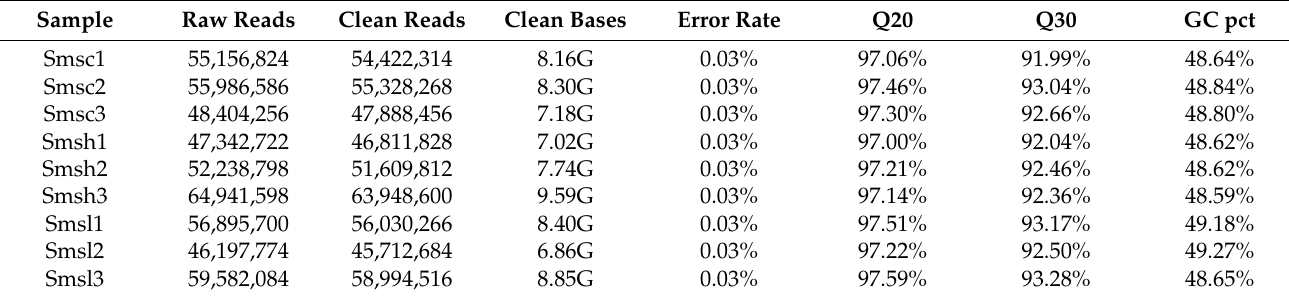
Table 2. Summary table of sequencing data